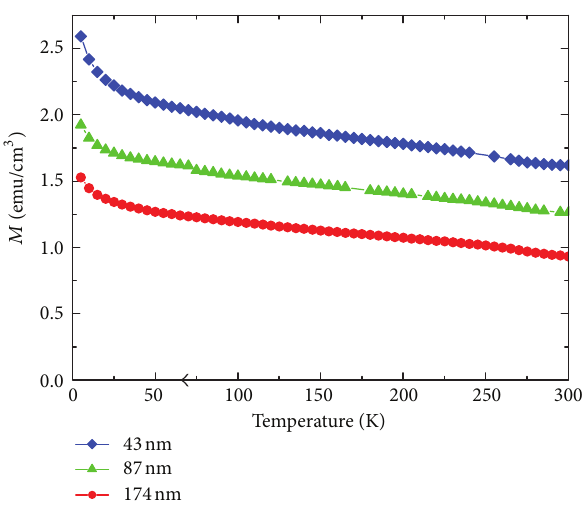
Figure 8: Magnetization as a function of temperature for BFO films of different thickness. The measurements have been done upon warming from 5K to 300 K in the presence of a 100Oe field after cooling under a field of 70kOe.